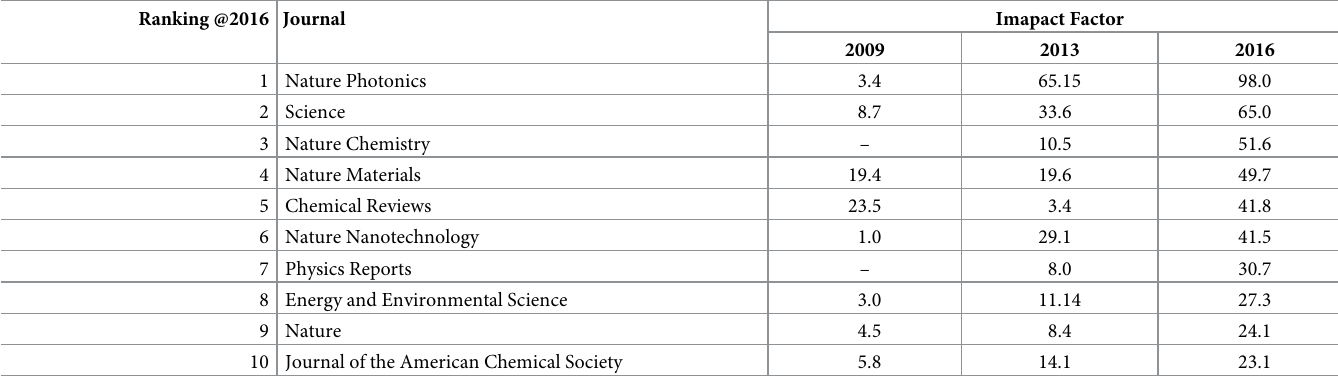
Table 5. Journal Impact Factor (JIF) ranking in the